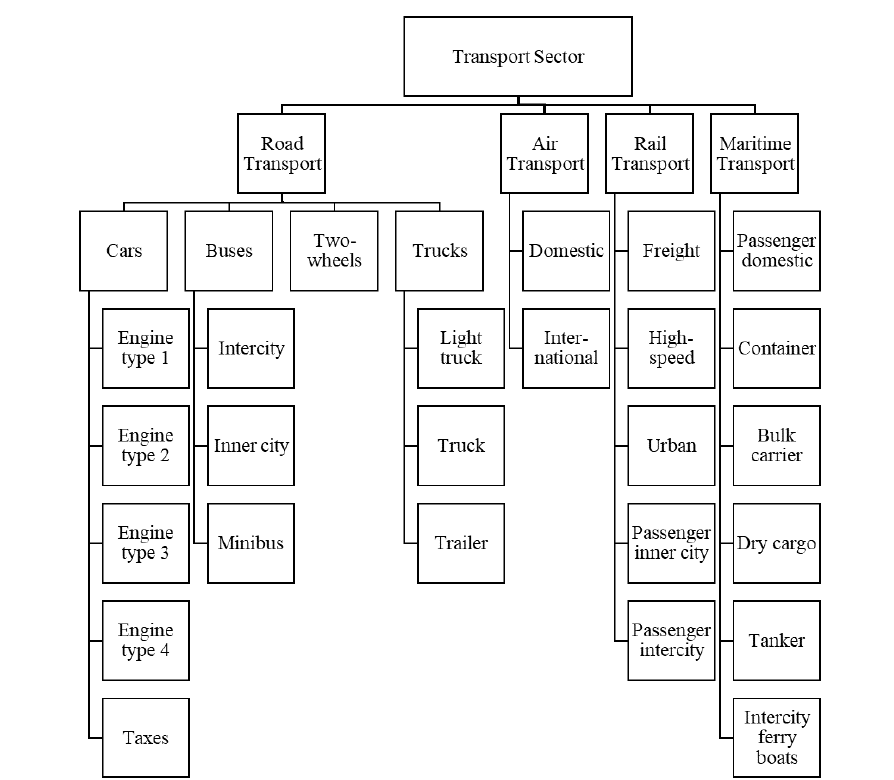
Figure 3. Sub-modes of the transport sector in